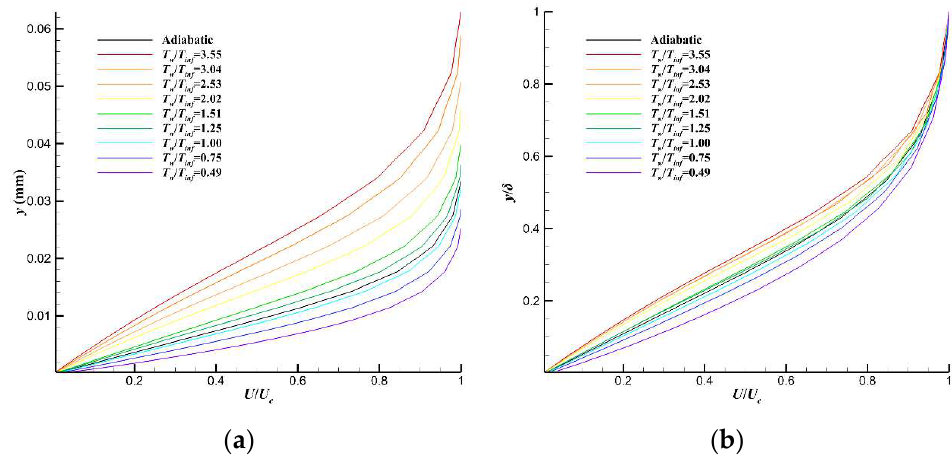
Figure 16. Velocity profiles of laminar boundary layers. ( a ) U/Ue v.s. y ; ( b ) U/Ue v.s. y/δ .